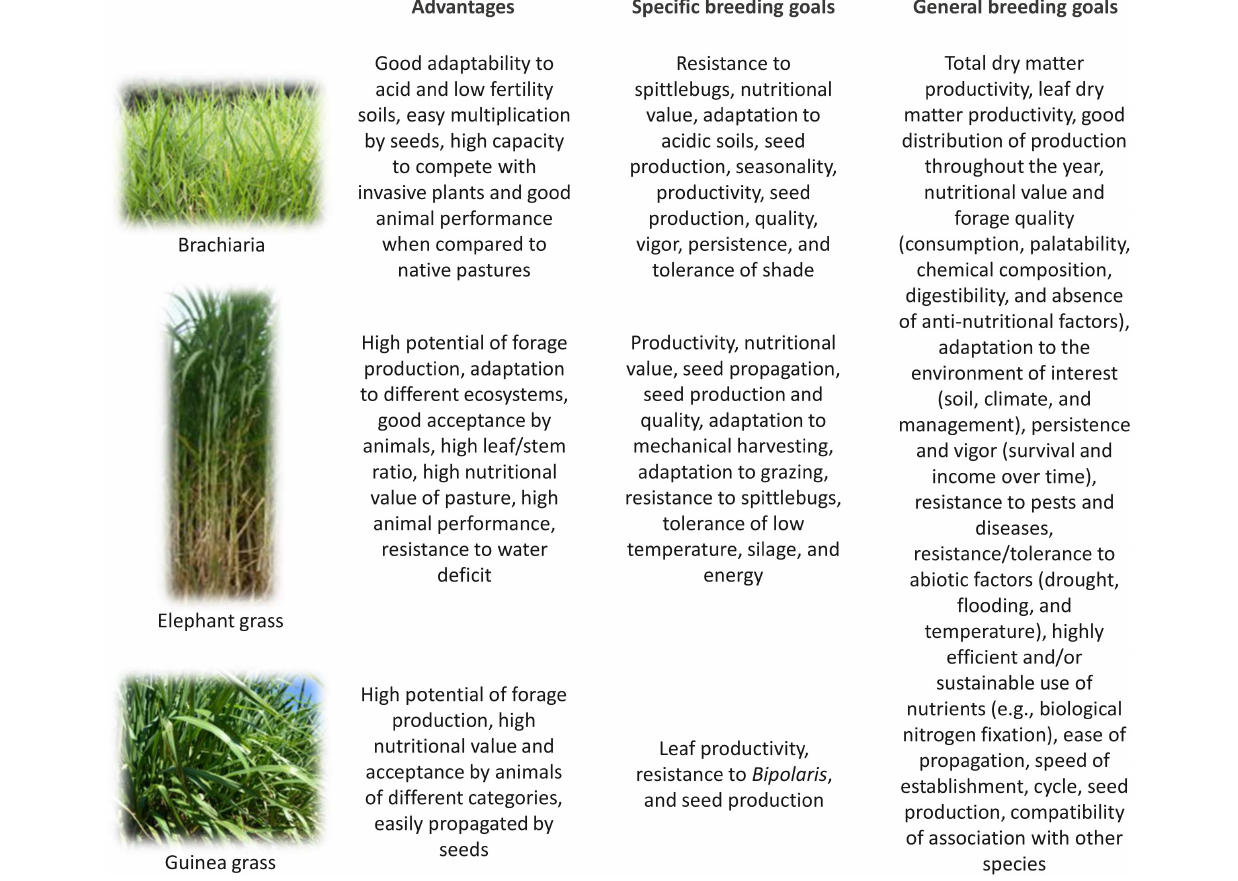
FIGURE 2 | Characteristics of brachiaria, Guinea grass, and elephant grass and breeding goals to improve their use as tropical forage grasses. The advantages and breeding goals are based on Machado et al. (2019). Source of the pictures: